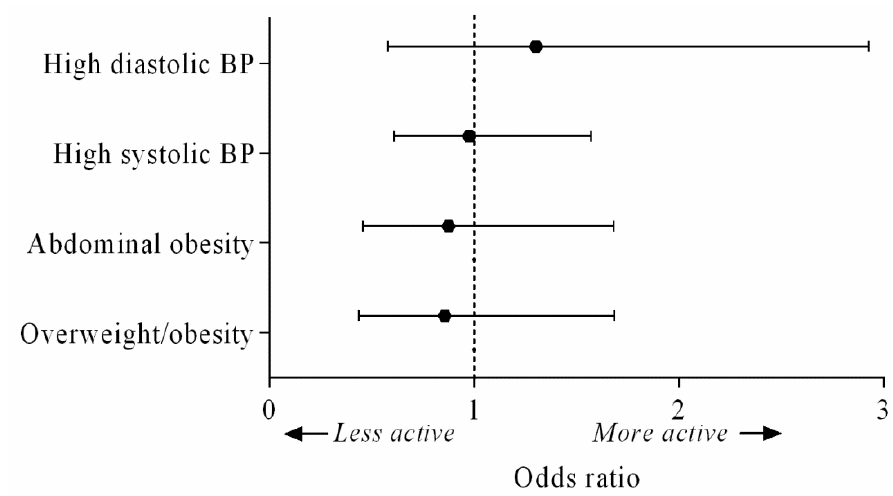
Figure 1. The odds of developing overweightness or obesity, abdominal overweightness or obesity, or prehypertension at the age of 10–11. The figure shows the odds ratios with 95% confidence intervals from the logistic regression models. The most active children were used as reference group. BP: blood pressure.